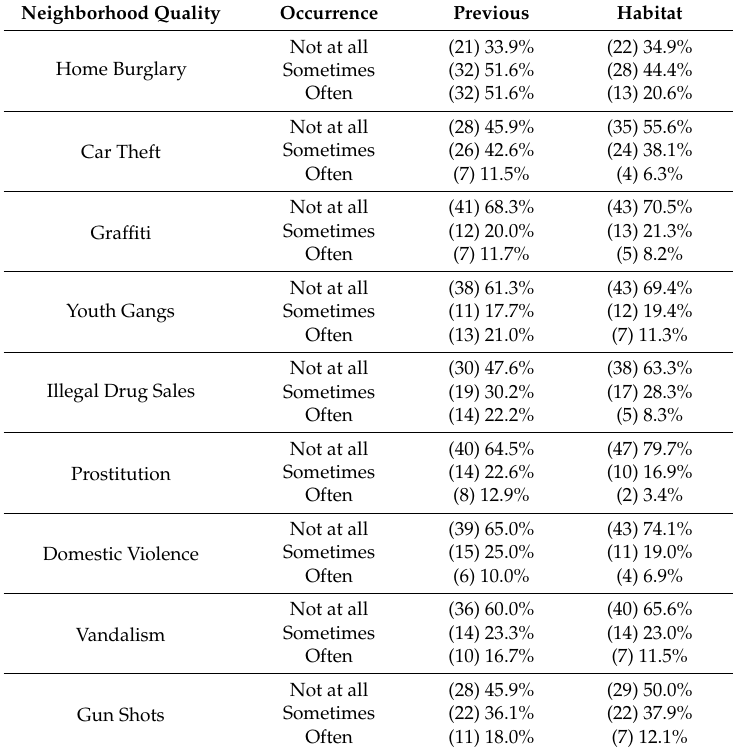
Table 6. Perceptions of Respondents Regarding Quality of Their “Previous” and “Habitat” Neighborhood-Crime.